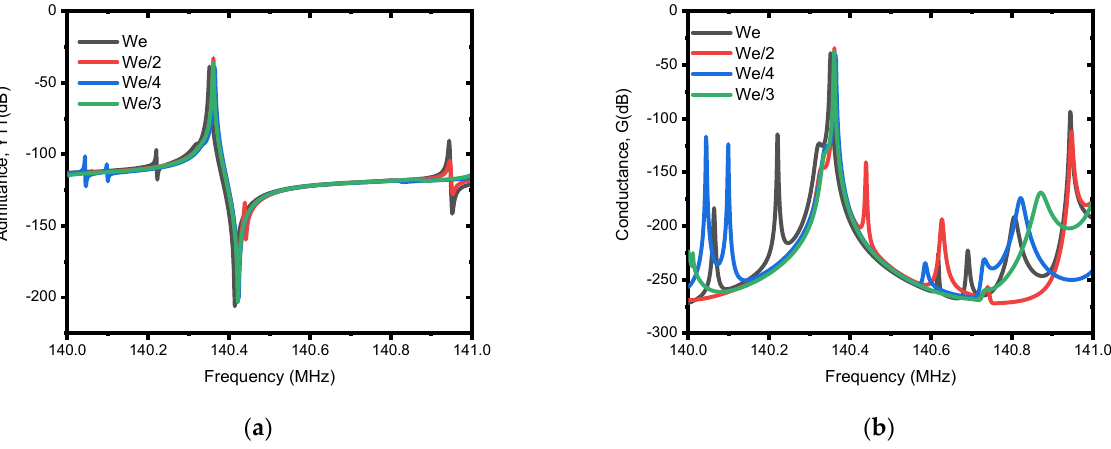
Figure 10. Illustration of simulated electrical responses using different patch lengths (i.e., W e /4, W e /3, W e /2 and W e ). The patch depth ( H patch ) of H m /2 and patch metal of tungsten (W) is used for the simulation. ( a ) Admittance, Y11 (dB), and ( b ) conductance, G (dB).